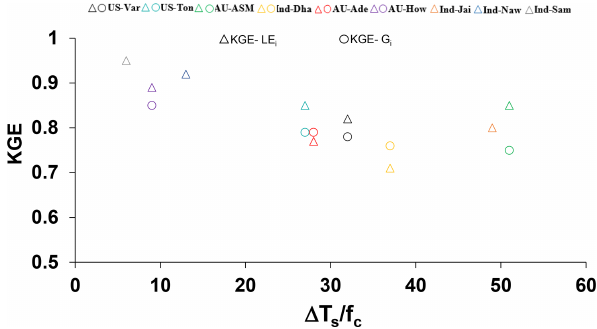
Figure 9. Relationship between the KGE of STIC-TI ( G i and LE i ) with (cid:49)T S /f c in different terrestrial